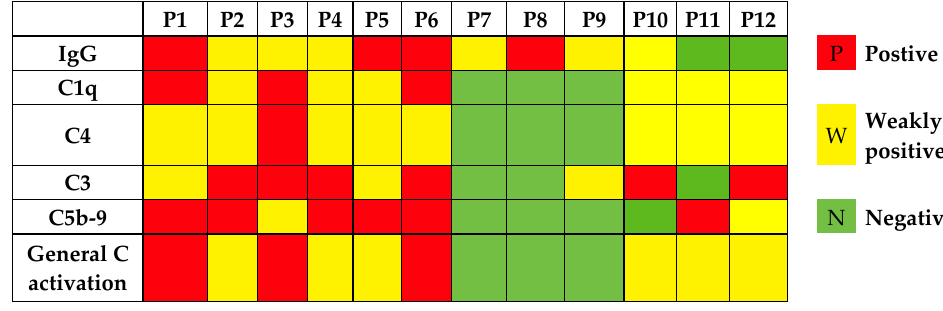
Figure 4. Detection of C3 and C5b-9 in kidney sections by immunofluorescence analysis. The panel shows representative immunofluorescence images obtained from the analysis of several sections of kidney autopsy samples from 12 SARS-CoV- 2-positive and 3 negative cases. See legend to Figure 1 for further details. White arrows in C3 image show periglomerular deposition; * in C5b-9 image shows glomerular staining. Scale bar = 50 µm. Table 4. Complement deposition in kidneys. Table 4. Complement deposition in kidneys.